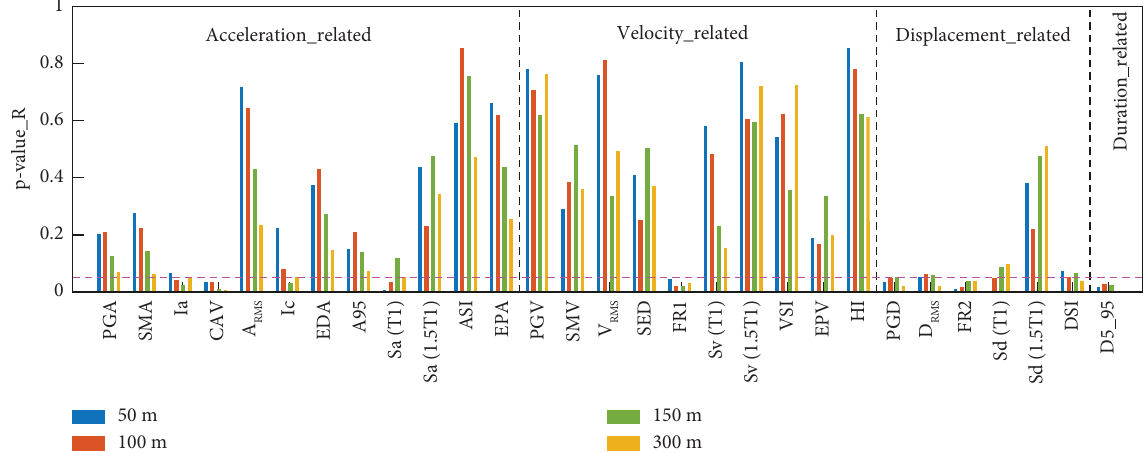
Figure 14: Sufciency comparison of 29 candidate IMs against R for the slopes with diferent mining depths.